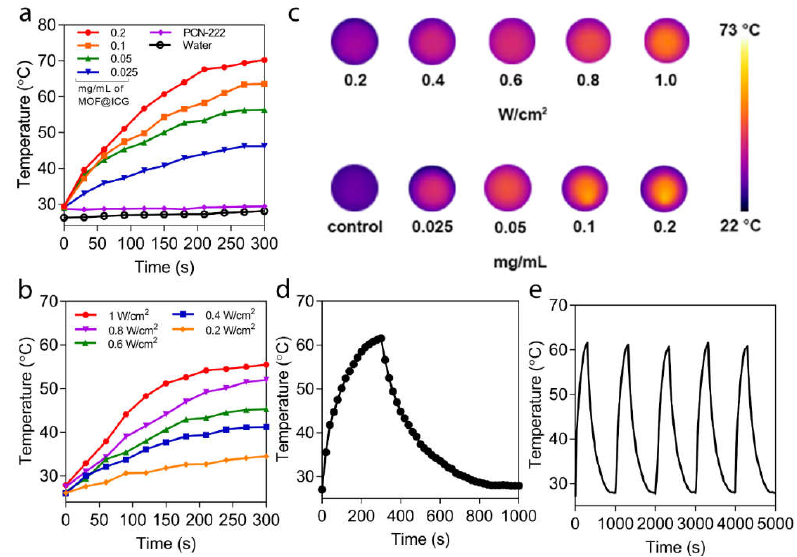
Figure 2. Photothermal effect of PCN−222@ICG. ( a ) Concentration-dependent temperature increase for PCN−222@ICG. Here, PCN−222 with a concentration of 0.2 mg mL −1 and a DI water sample are used as control groups. ( b ) Power-density-dependent temperature increase of PCN−222@ICG. ( c ) Thermal images of PCN−222@ICG probes for various concentrations and power-densities. ( d ) Single heating/dissipation cycle of PCN−222@ICG. ( e ) Photothermal stability testing of PCN−222@ICG for five cycles.